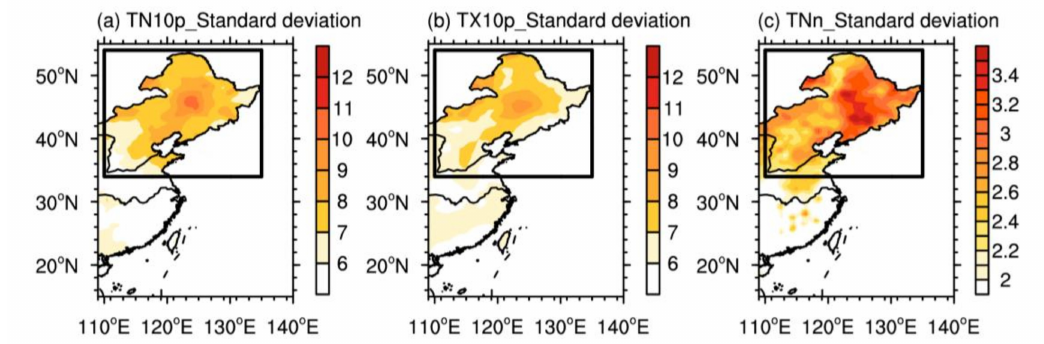
Figure 2. The distribution of standard deviation (shaded) of ( a ) TN10p (unit: days), ( b ) TX10p (unit: days), and ( c ) TNn (unit: ◦ C) in eastern China during the 1979–2015 winters. The black box is the NEC region (35 ◦ N–55 ◦ N, 110 ◦ E–135 ◦